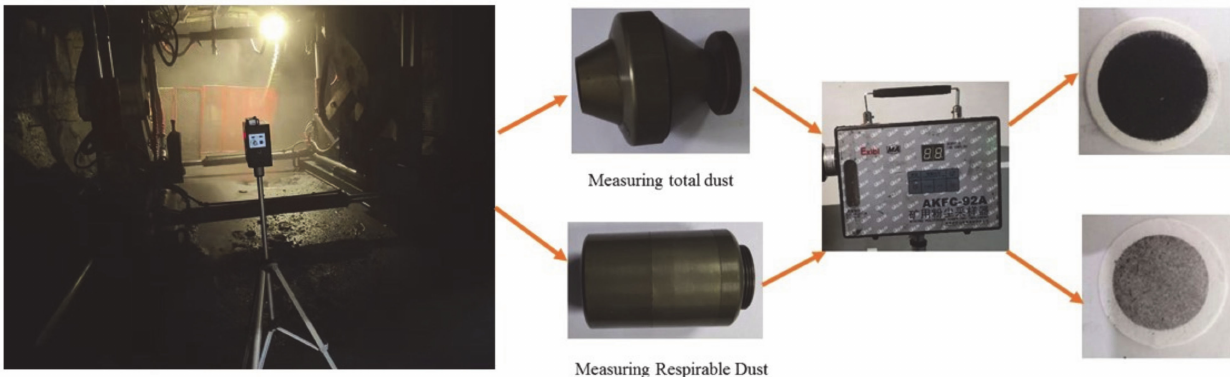
Figure 13. Dust concentration measuring